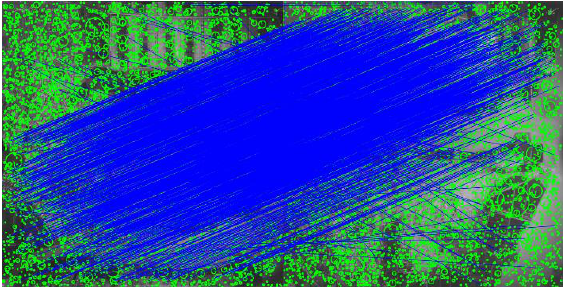
Figure 11. The result of SIFT matching.